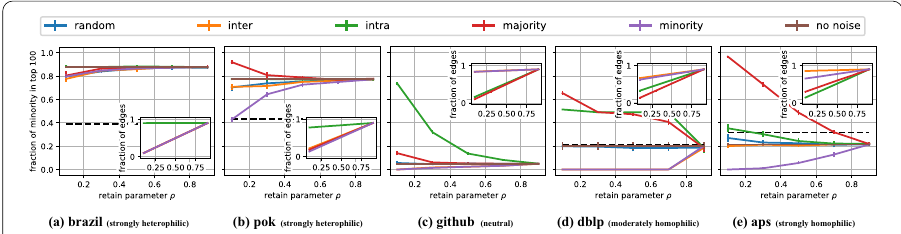
Fig. 5 Effect of node attribute-based noise on real datasets. Similar to Fig. 3 we plot the influence of the retain parameter ρ on networks with different strength of homophily. Networks are sorted by modularity of their label partition which can be seen as a proxy for homophily, if the connectivity of the network is indeed driven by homophily. However, the networks here do not have a one-to-one correspondence with the synthetic networks regarding minority size and homophily. Nonetheless we can see that similar effects are present in real and synthetic world networks, with dblp being the notable exception where some saturation happens already at around ρ = 0.7